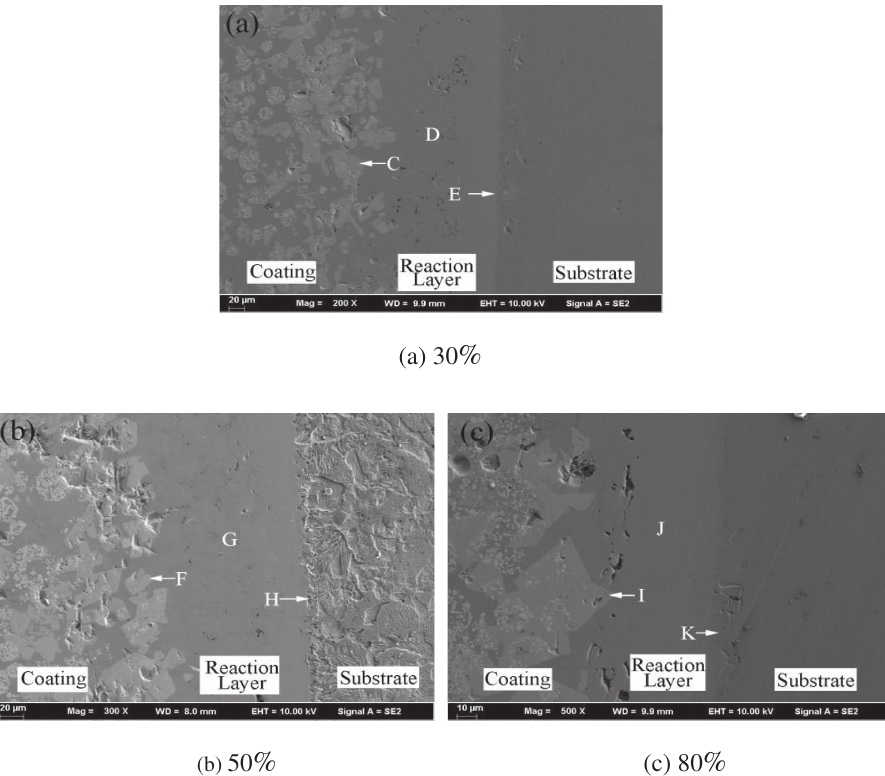
Figure 4: microscopic morphology and microstructure of reaction layer between coating and substrate:(a) 30%, (b) 50%,